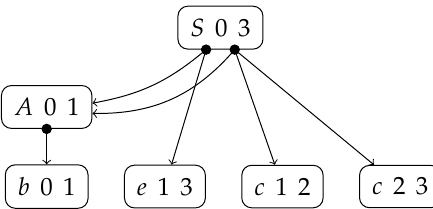
Figure 20. The SPPF for the specification Ξ in (3) and ω “ xyz